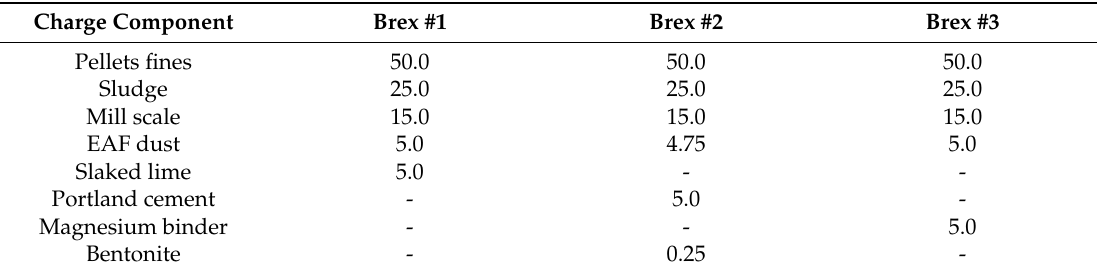
Table 2. Experimental brex compositions, %.